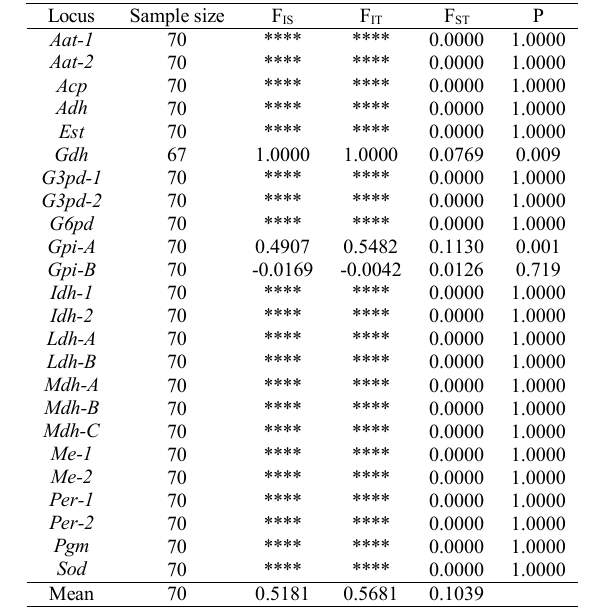
(Table 3) value and the genetic distance values (Table 2) indicate that the four samples are genetically very similar to each other, with moderate genetic differentiation.